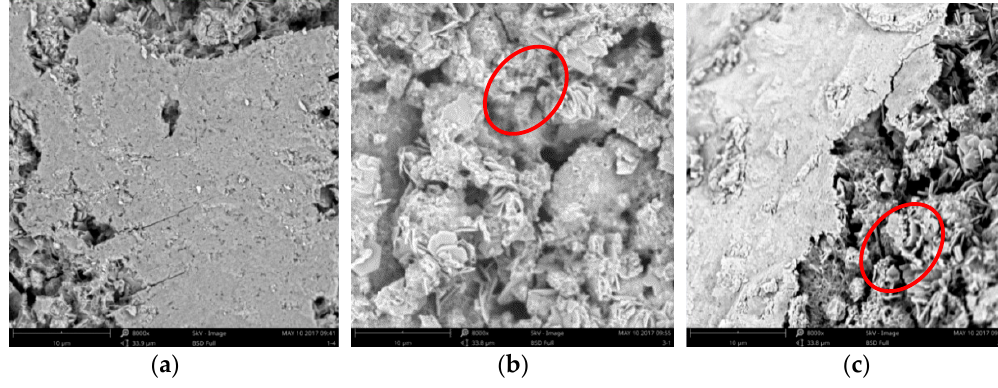
Figure 16. Scanning electron microscope (SEM) images of different samples. ( a ) Reference sample; ( b ) electrochemical chloride extraction (ECE) treated sample; ( c ) imidazoline inhibitor (IM) treated sample.